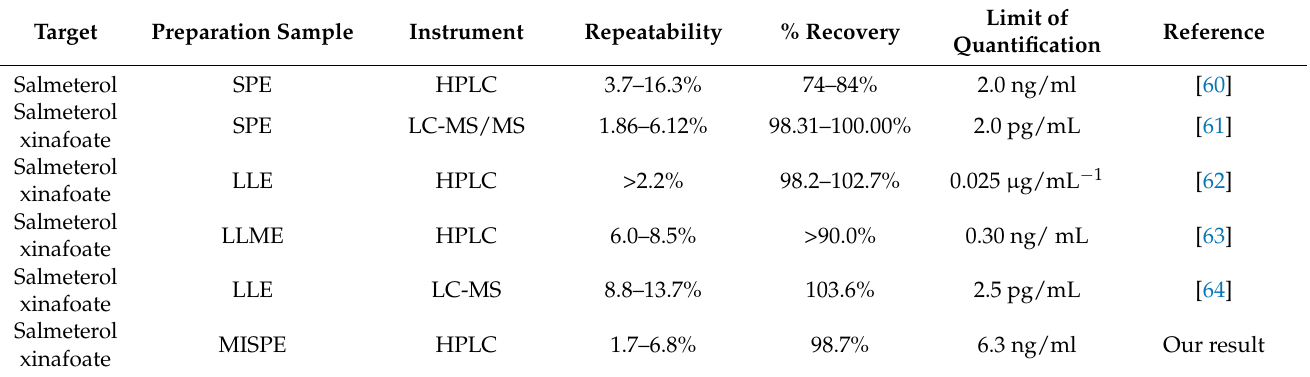
Table 3. Comparison of repeatability, recovery, and LOQ values with other research studies.